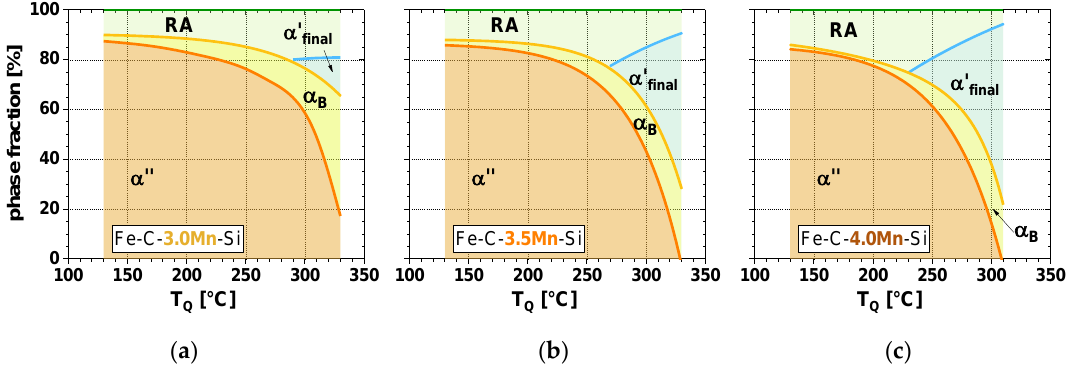
Figure 5. Phase fraction as a function of T Q for the ( a ) Fe-C-3.0Mn-Si, ( b ) Fe-C-3.5Mn-Si, and ( c ) Fe-C-4.0Mn-Si steels.